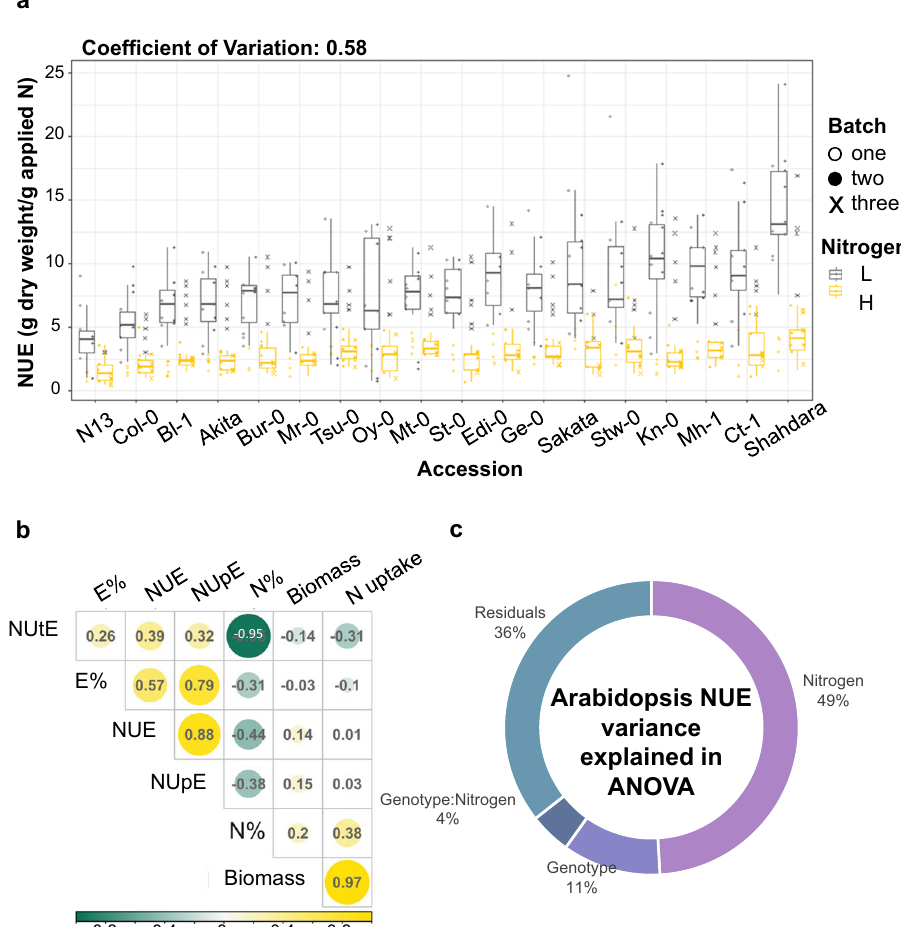
Fig. 2 Nitrogen is the leading factor explaining the NUE variation across Arabidopsis natural acesssions. a Boxplot of NUE among the Arabidopsis genotypes measured in three independent batches. The coef fi cients of variation demonstrate the broad range of phenotype of this panel of genotypes, which has been widely used in NUE studies. The X -axis is ordered in the increasing value of average NUE. In the box plots, the box represents the 25th to 75th percentile and the line within the box marks the median. Whiskers above and below the box indicate the 10th and 90th percentiles. Points above and below the whisers indicate outliers outside 10th and 90th percentiles. b The correlation of traits measured in this study . NUE at the pre-bolting stage is highly correlated with NUpE. Biomass, g/plant; N uptake, mg N/plant; N%, N uptake/Biomass; E%, 15N uptake/N uptake; NUE, Biomass/applied N;